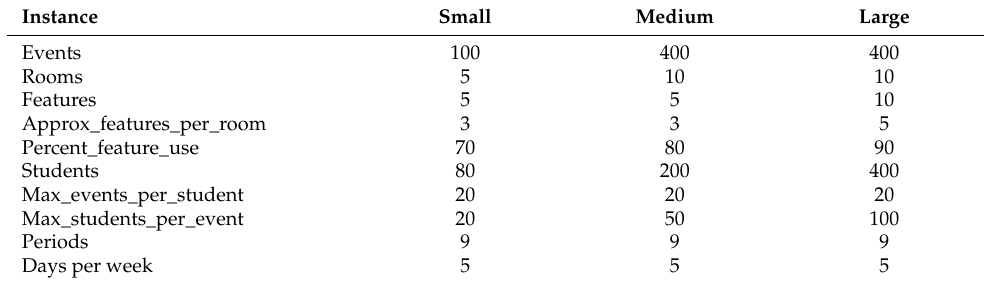
Table 2. Characteristics of the instances.